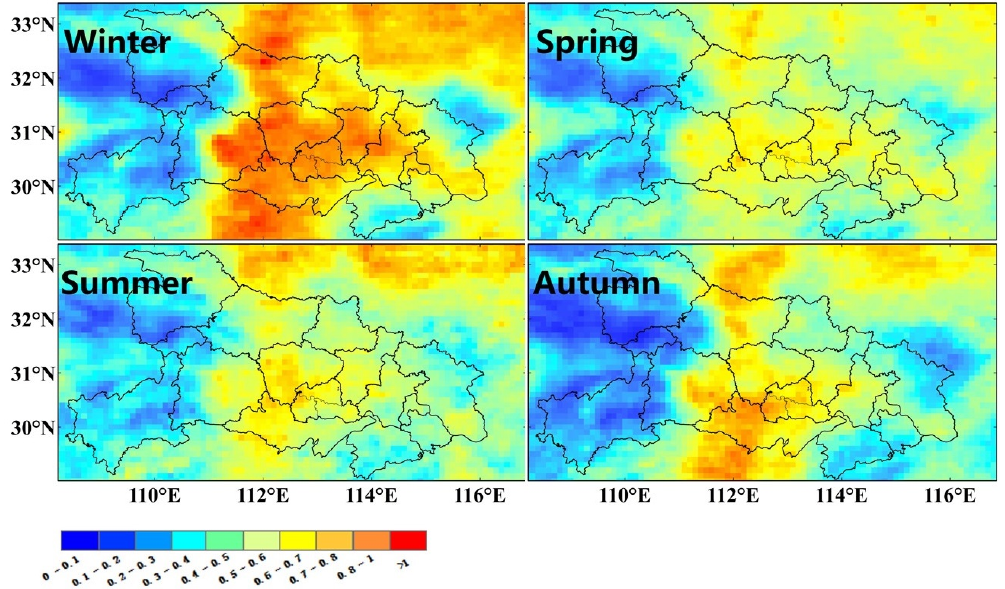
Figure 11. Seasonal MODIS Dobson unit (DU) AOD at 550 nm during 2013–2017.